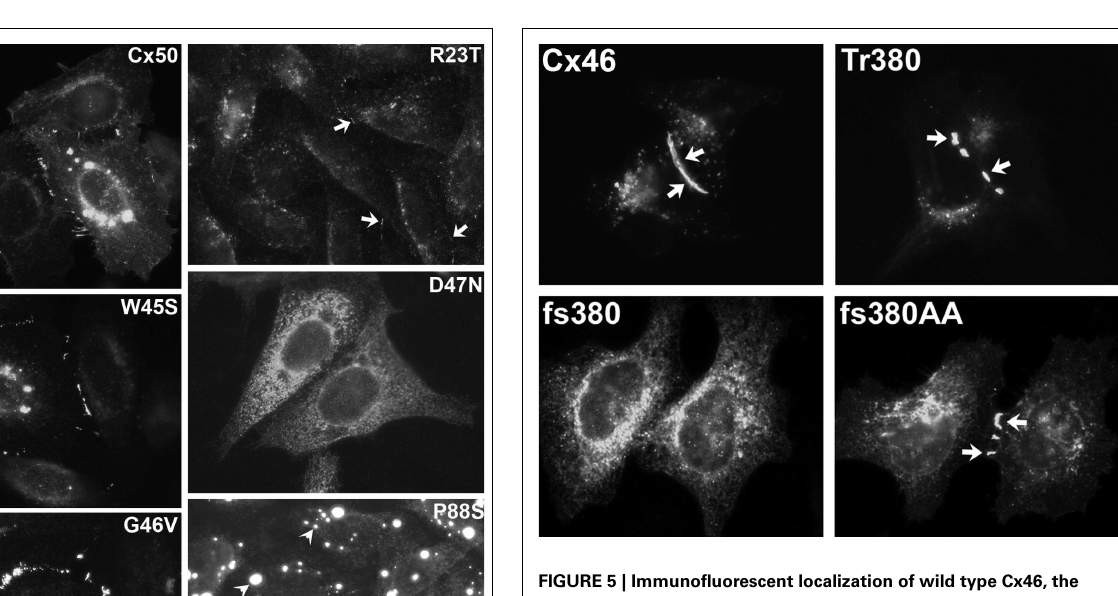
FIGURE 5 | Immunofluorescent localization of wild type Cx46, the cataract-associated mutant Cx46fs380 (fs380), Cx46 truncated after amino acid 379 (Tr380) and Cx46fs380 with the FF motif replaced by AA (fs380AA) in transfected HeLa cells. Wild type Cx46 localizes in an intense, linear distribution along appositional membranes as expected for large gap junctions, but such staining is absent for Cx46fs380 which is only found in a cytoplasmic distribution.The cytoplasmic retention must be due to the abnormal sequence in the carboxyl terminus of Cx46fs380, since its removal by truncation (Tr380) restores gap junction formation. Similarly, gap junction formation is restored when the FF motif in Cx46fs380 is replaced with two alanines (fs380AA). Reproduced and adapted from Minogue et al.